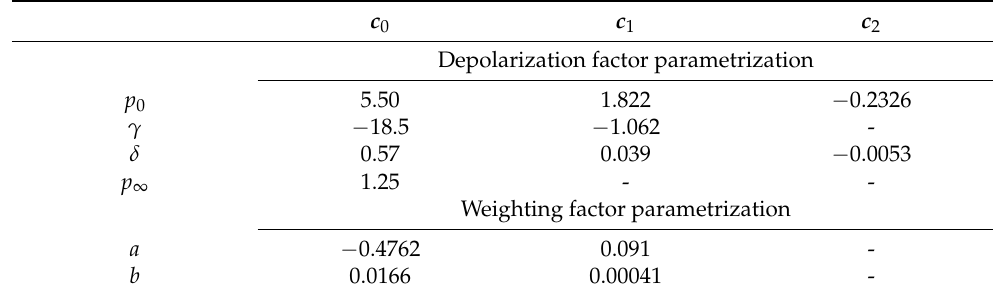
Table 1. The NLEM model parametrization.